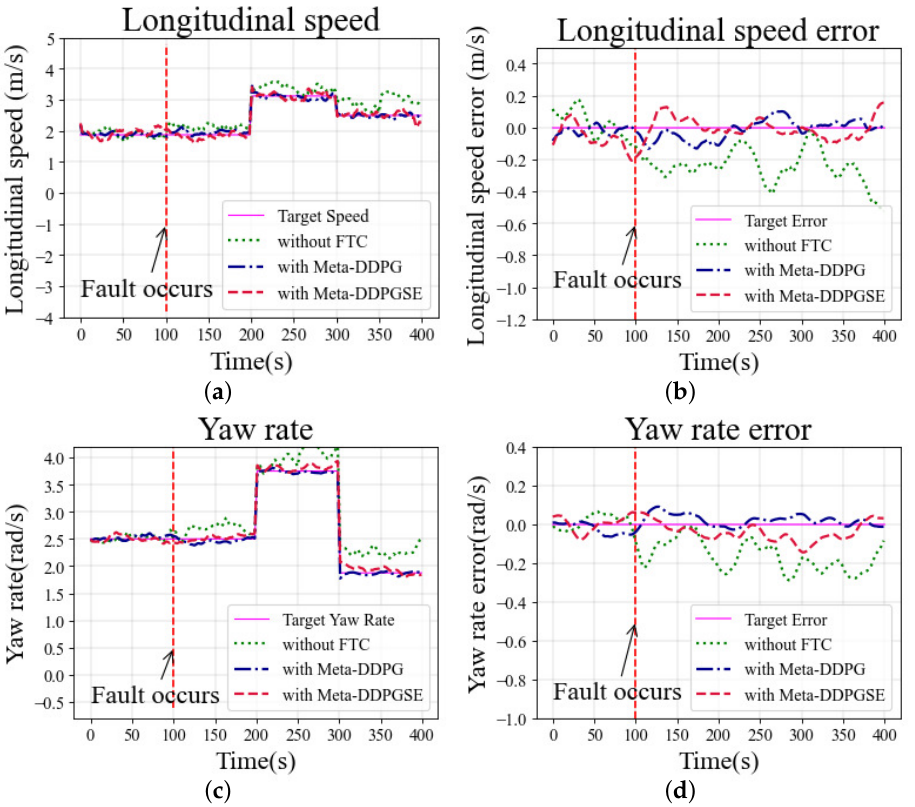
Figure 12. Simulation results in the cornering scenario with fault F ∗ gitudinal speed error; ( c ) Yaw rate; ( d ) Yaw rate error.